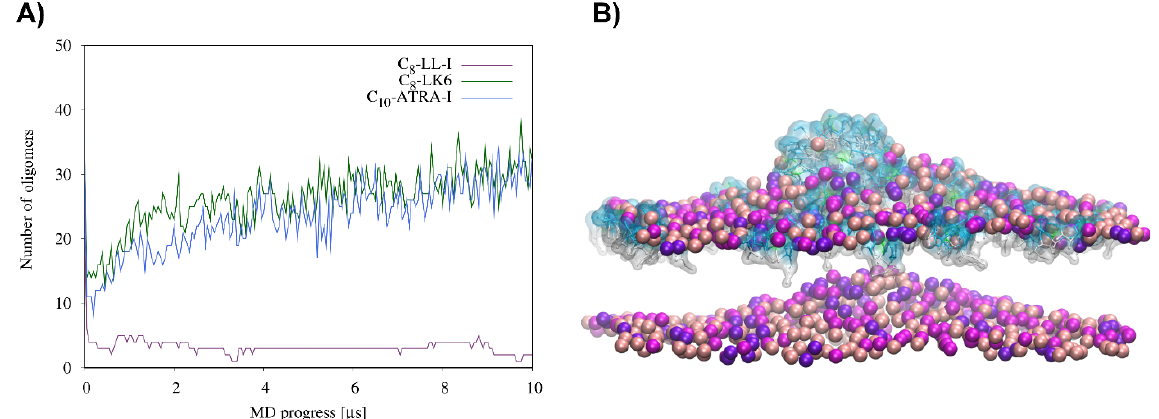
Figure 7. ( A ) Analysis of the self-assembly process of the lipopeptides in the presence of the DPPG/LysPG (lysyl-phosphatidylglycerol)/CDL2 (cardiolipin) bilayer as a function of simulation time. Two peptide molecules were classified into the same oligomer if any of their beads fell within the distance of 6 Å of each other. ( B ) Snapshot from the DPPG/LysPG/CDL2 binding CG MD simulations for C 8 -LK6, showing the lipopeptide micelle insertion at 9 µs. For clarity, only phosphate beads of the membrane are displayed. The DPPG, LysPG and CDL2 phosphate groups are indicated in pink, magenta and violet, respectively. Oktanoyl tails and nonpolar amino acids are in white, positively charged residues are in cyan, while polar noncharged residues are in green.